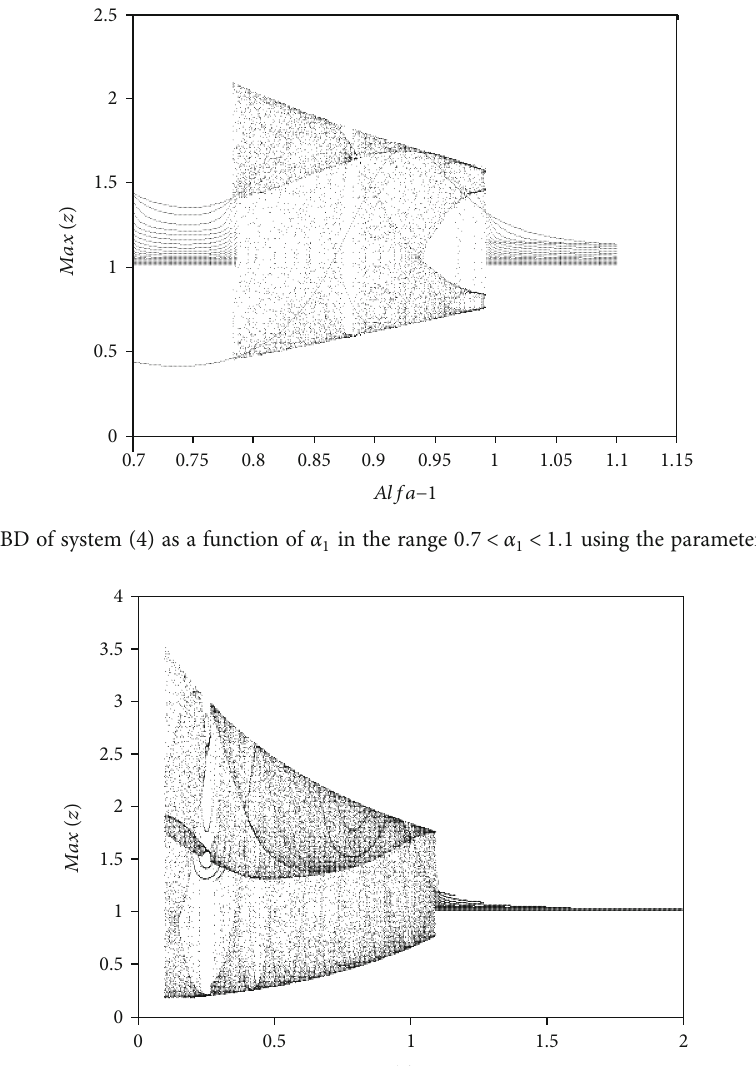
Figure 13: The BD of system (4) as a function of α